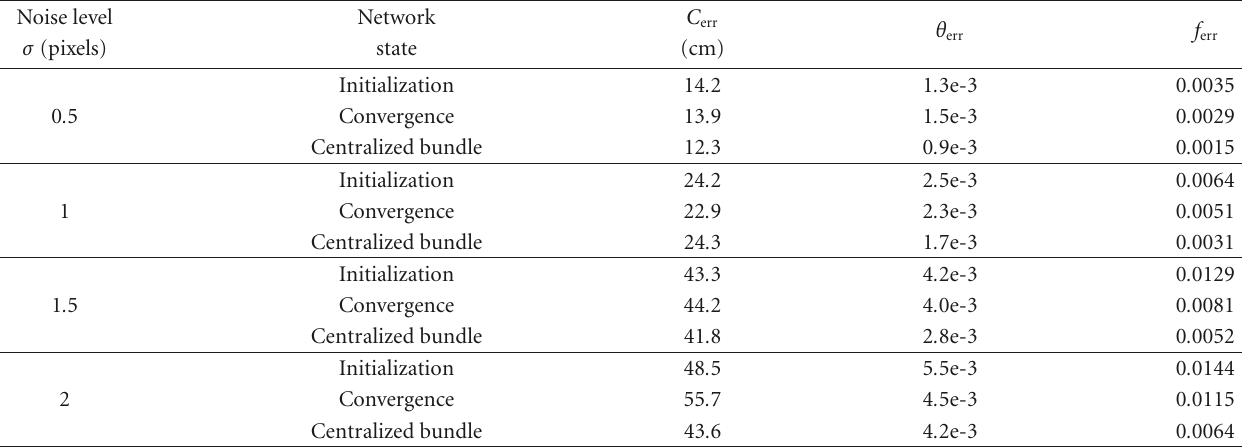
Table 1: Summary of the calibration accuracy. C err is the average absolute error in camera centers in cm (relative to a scene width of 220m). θ err is the average orientation error between rotation matrices given by (15).